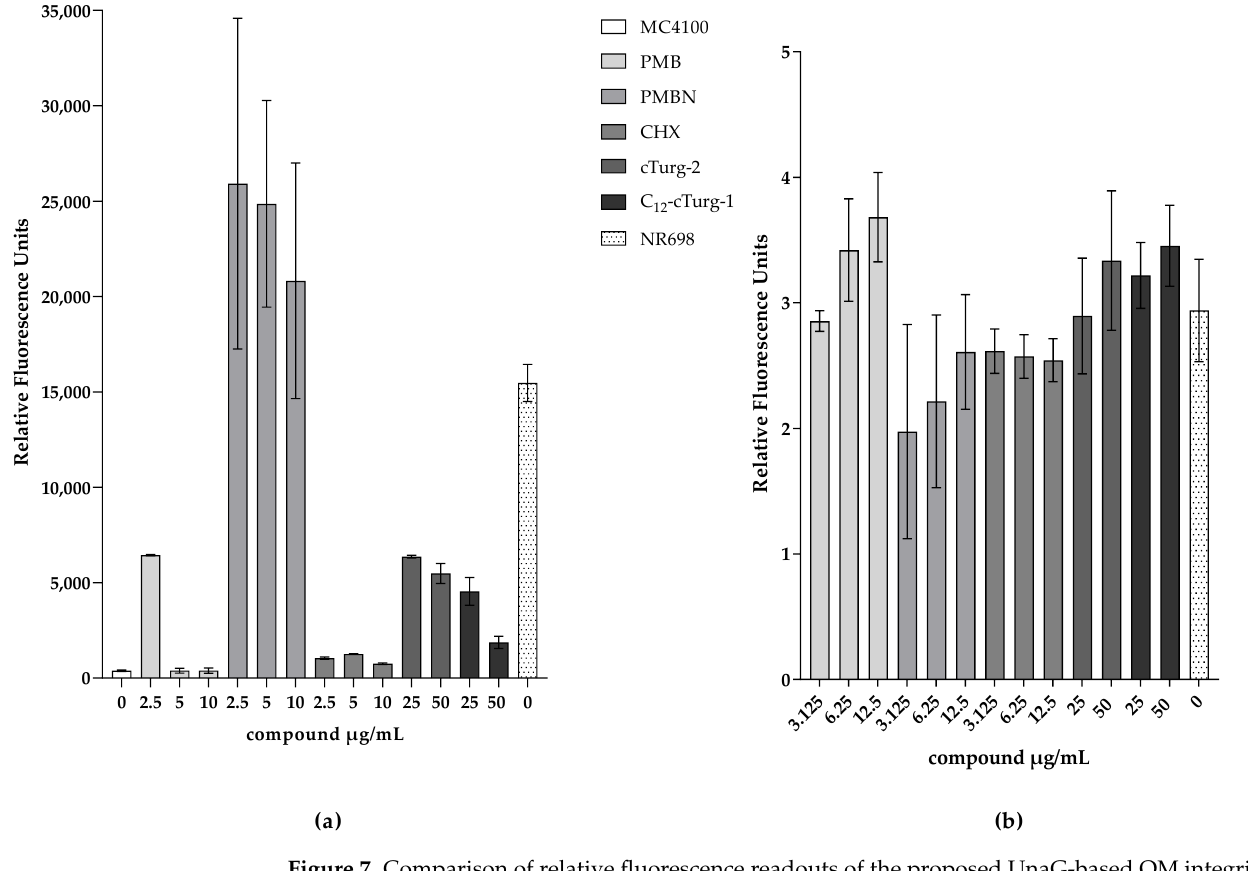
Figure 7. Comparison of relative fluorescence readouts of the proposed UnaG-based OM integrity biosensor and the traditional NPN assay in response to membrane damage. Representative fluorescence values from three independent measurements are shown. ( a ) Fluorescence of MC4100 constitutively expressing UnaG from pMM001 in 0.9% NaCl 10 h after addition of 5 µ M BR and indicated concentrations of OM- or plasma-membrane-active compounds. The measurements were blanked to the respective control without BR. ( b ) Normalized fluorescence in presence of NPN and different concentrations of OM- or plasma-membrane-active compounds in 5 mM HEPES after 3 min to the MC4100 control with NPN and only water.